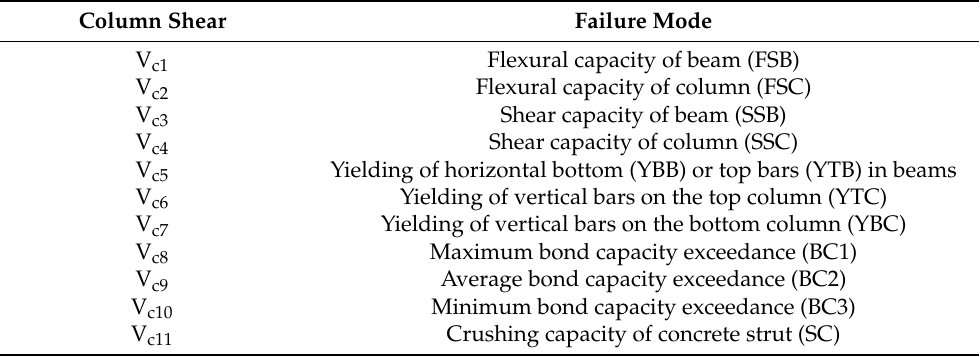
Table 1. Ultimate column shear, V c , due to each linked failure mode. Column